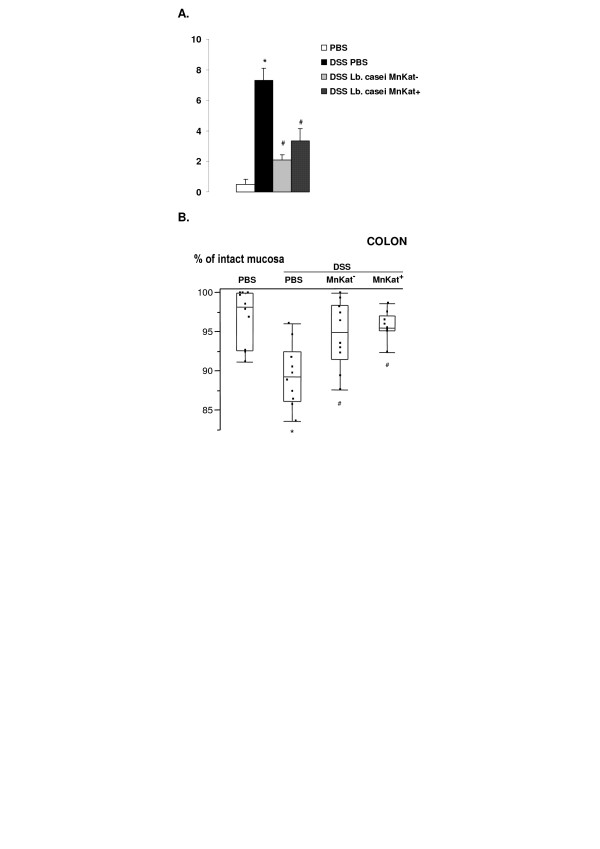
Effects of Lb. casei BL23 on the inflammation. A. Total macroscopic score. Total macroscopic score was the sum of caecal and colonic scores. Data are expressed as mean ± SEM, n = 10/treatment. (*) P < 0.05 versus no inflammation group (PBS) and (#) versus inflamed control group (PBS DSS). B. Histological score. This parameter is expressed as percentage of intact mucosa and presented using box-and-whisker plots, n = 10/treatment. (*) P < 0.05 versus no inflamed group (PBS) and (#) versus inflamed control group (PBS DSS).